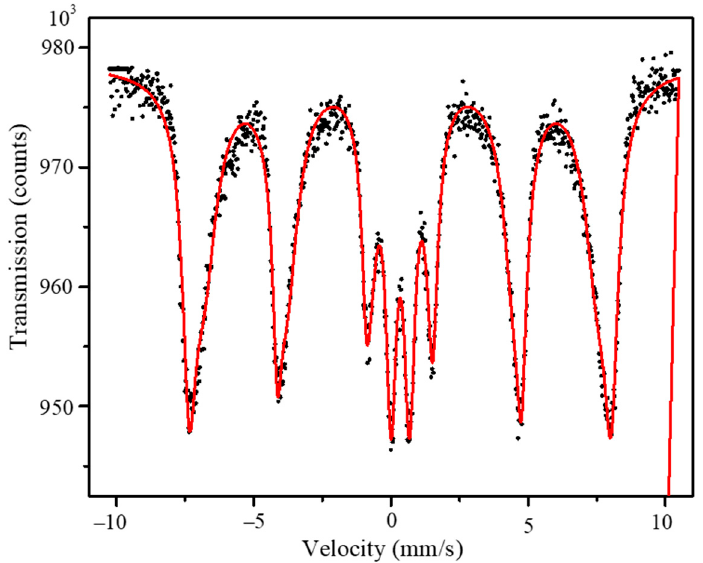
Figure 4. Room temperature Mössbauer spectrum of Co 0.2 Mn 0.8 Fe 2 O 4 . The dots represent the experimental data and the red solid line represents the fitting.